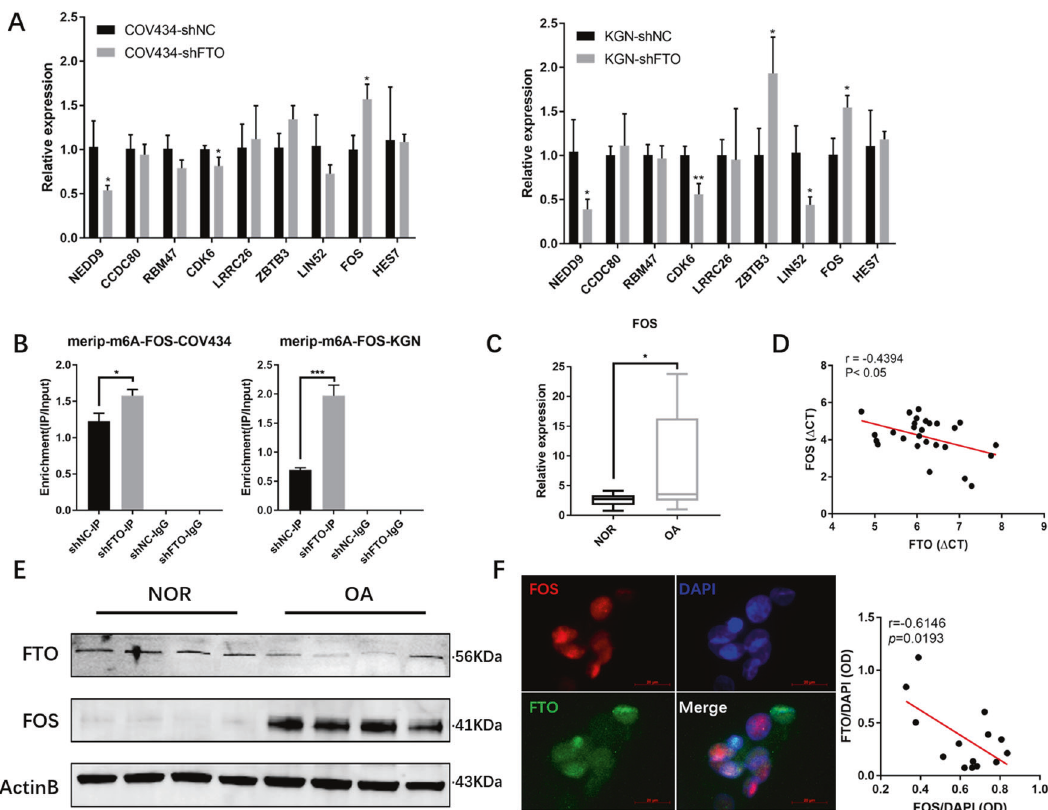
Fig. 3 FOS is the m6A erasing target of FTO in GCs. A RT-PCR showed the relative expression of 11 potential target genes in COV434-shFTO/ COV434-shNC and KGN-shFTO/KGN-shNC. B Immunoprecipitation of m6A-modi fi ed RNA in control or FTO-knockdown cells followed by